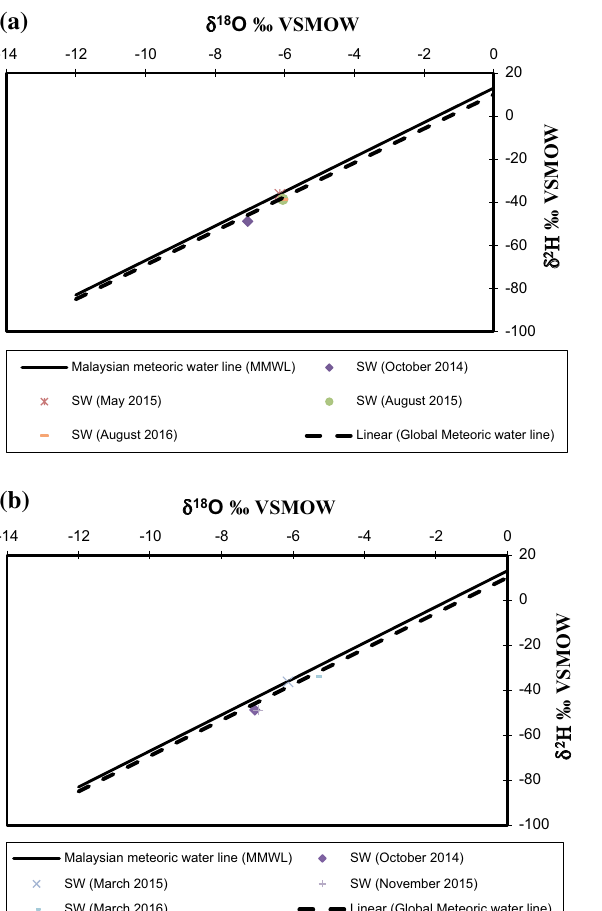
Fig. 5 Plot of δ 2 H versus δ 18 O for river water samples during a dry season and b wet seasons